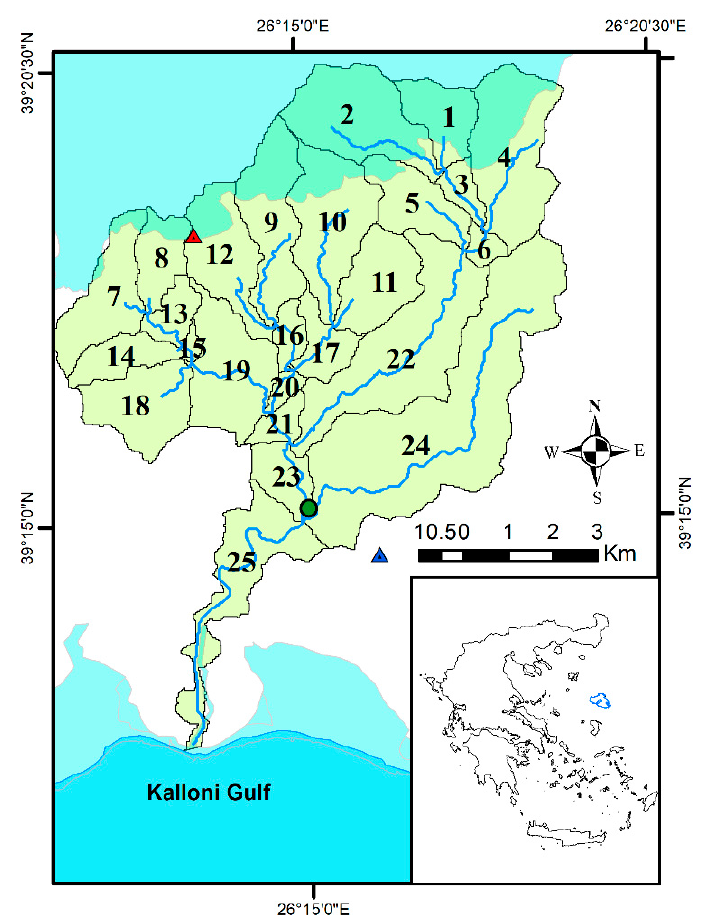
Figure 1. Map of the study area with stream network. The numbers represent subbasin division from SWAT model. Triangles represent meteorological stations: red for Stypsi station and blue for Agia Paraskevi. The circle represents Prini gauging station. The light blue represents Natura 2000 areas of the island.